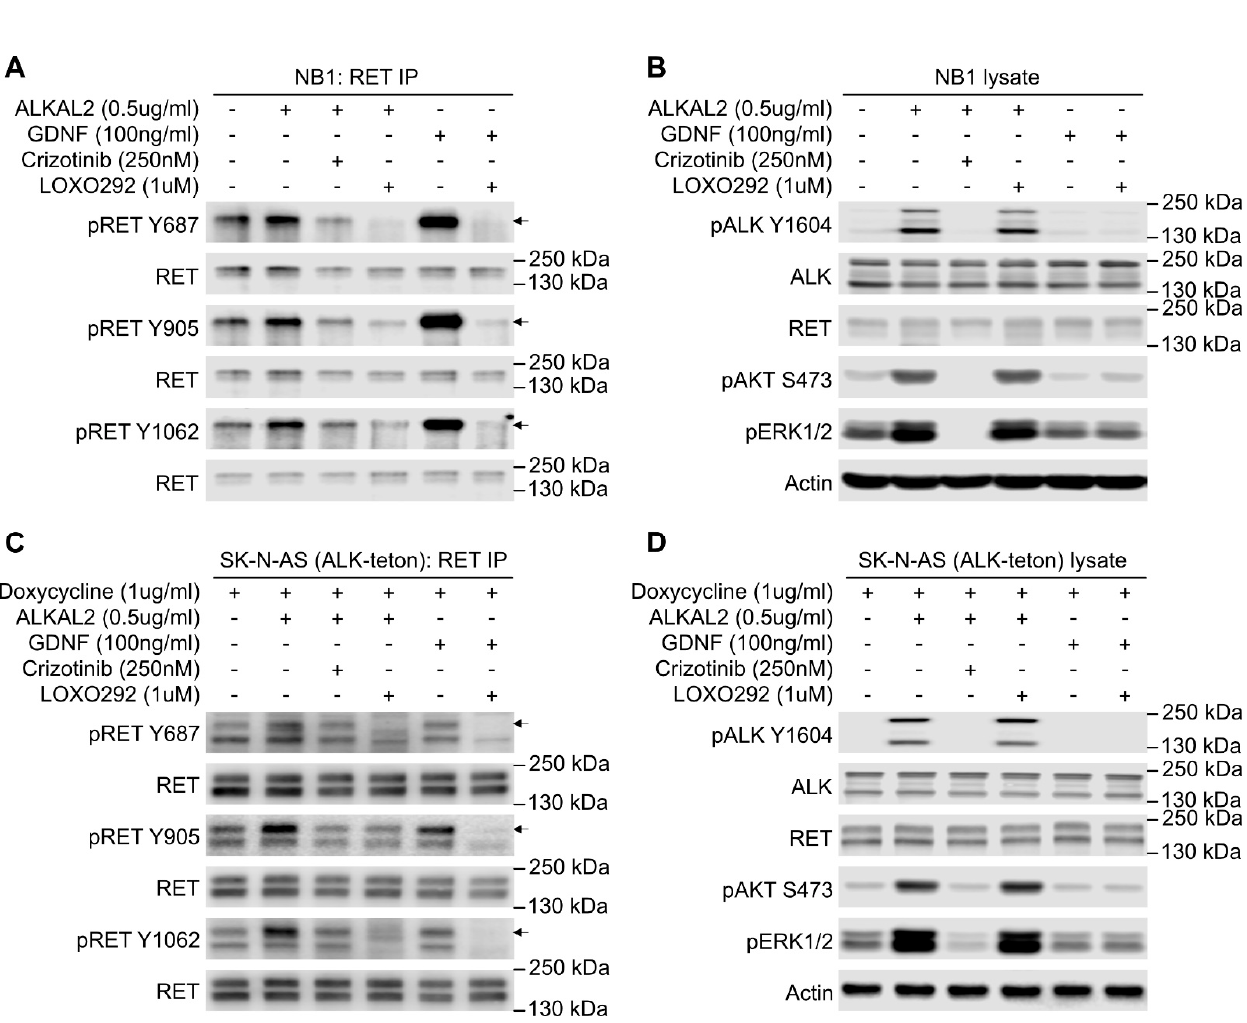
Figure 1. Anaplastic lymphoma kinase (ALK) activation leads to rearranged during transfection (RET) phosphorylation. ( A ) Western blot analysis of RET immunoprecipitates (IPs) from NB1 cells treated with combinations of either ALKAL2, glial cell line-derived neurotrophic factor (GDNF), crizotinib, or LOXO292 as indicated. Phospho-RET antibodies were used to indicate RET activation, and blots reprobed with RET antibody were used as control. ( B ) Corresponding NB1 cell lysates were blotted to show activation of ALK and downstream signaling. Total ALK, RET, and actin were used as loading controls. ( C ) Western blot analysis of RET immunoprecipitated from ALK-inducible SK-N-AS cells which express ALK upon addition of doxycycline. Cells were treated as in ( A ), with combinations of ALKAL2, GDNF, crizotinib, or LOXO292 as indicated. Phospho-RET antibodies were used to indicate RET activation, and blots reprobed with RET antibody were used as control. ( D ) Corresponding ALK-inducible SK-N-AS (ALK-teton) cell lysates were blotted to show activation of ALK and downstream signaling. Total ALK, RET, and actin were used as loading controls. Arrows indicate a slower migrating form of RET that likely corresponds to surface RET protein.